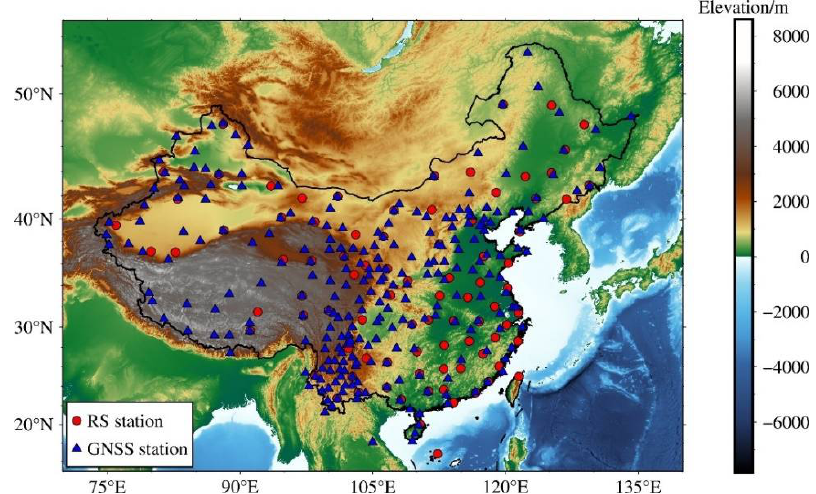
Figure 1. Distribution of selected GNSS and RS stations in China.